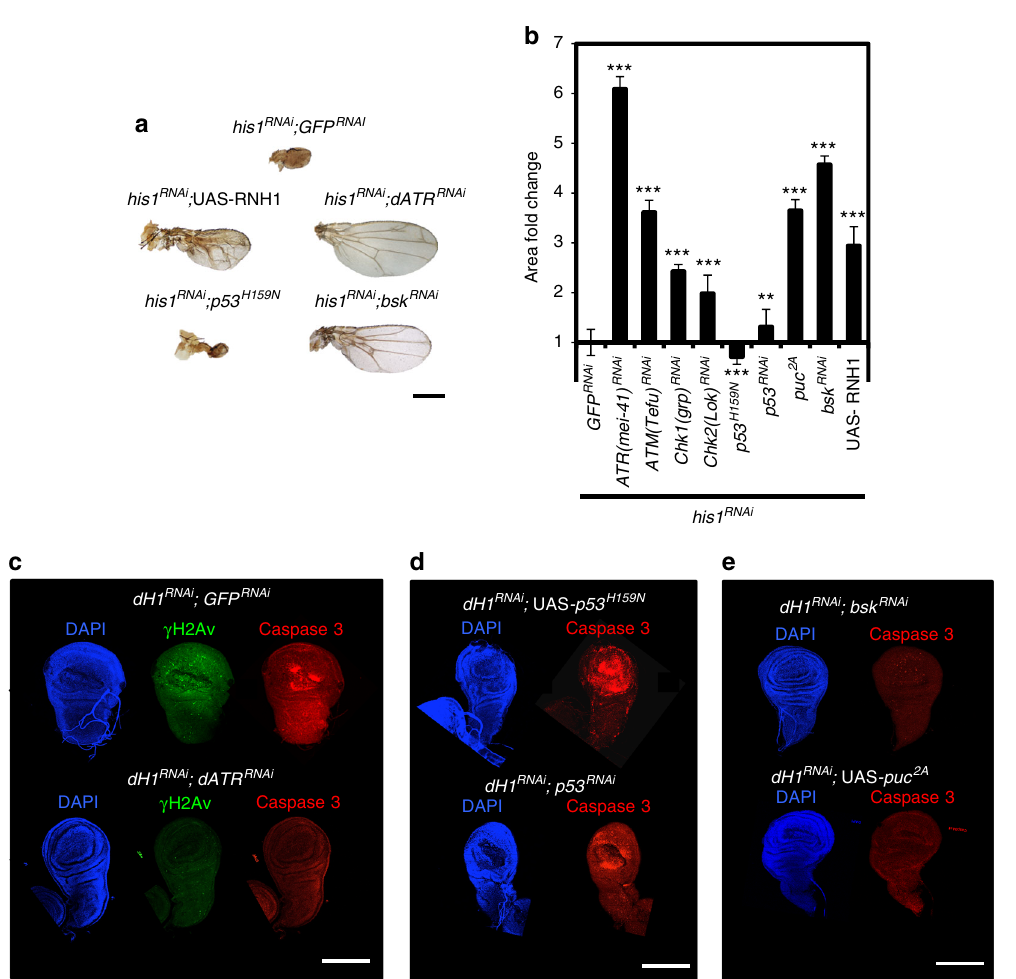
Fig. 8 R-loops induced by dH1 depletion activate JNK-dependent apoptosis. a Wings from dH1-depleted his1 RNAi fl ies of the indicated genotypes where dH1 depletion was induced in the pouch region of the wing imaginal disc. Scale bar corresponds to 500 μ m. b Quantitative analysis of the wing area of dH1-depleted his1 RNAi fl ies of the indicated genotypes. Data is expressed as fold change respect to control dH1-depleted his1 RNAi ; GFP RNAi ( n > 20 for each condition). Error bars are s.e.m. The p -values respect to control his1 RNAi ; GFP RNAi are indicated (** < 0.01, *** < 0.005; two-tailed Student ’ s t -test). c Immunostaining with αγ H2Av ( green ) and α Caspase 3 ( red ) of wing imaginal discs from dH1-depleted his1 RNAi fl ies upon d ATR RNAi co-depletion ( bottom ) or not ( top ). DNA was stained with DAPI ( blue ). d Immunostaining with α Caspase 3 ( red ) of wing imaginal discs from dH1-depleted his1 RNAi fl ies upon p53 RNAi co-depletion ( bottom ) or p53 H159N overexpression ( top ). DNA was stained with DAPI ( blue ). e As in d but upon bsk RNAi co-depletion ( top ) or puc 2A overexpression ( bottom ). Scale bars in c – e are 200 μ